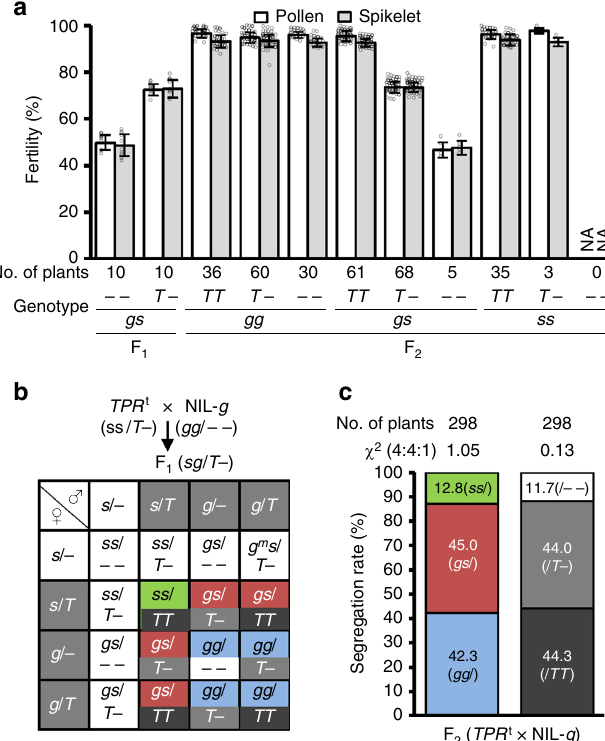
Fig. 2 The S1TPR t rescues the gametes carrying S1-s in hybrids. a Pollen and spikelet fertilities of the F 1 plants derived from the cross between the hemizygous S1TPR t ( TPR t , ss / T – ) and NIL- g ( gg / – – ), and various genotypes of the F 2 segregants. Error bars indicate S.D. NA, not available. b A proposed model for the segregation behavior of the endogenous S1 alleles and TPR t in the F 2 plants derived from TPR t × NIL- g . The F 1 male and female gametes containing S1-g and/or T are considered fertile, and those with S1-s ( ss / – – ) but lacking T are generally sterile. Thus, the expected segregation ratios for gg : gs : ss and TT : T – : – – are 4:4:1. The color codes are consistent with the genotype of the individuals in the F 2 population. Black represents homozygous TPR t ; gray represents hemizygous TPR t ; white represents lacking TPR t ; green represents homozygous S1-s ; red represents heterozygous S1 ; blue represents free homozygous S1-g . c The segregation rates of the S1 alleles and the transgene ( T ) in the analyzed F 2 population fi t the expected ratio. Source data of ( a , c ) are provided as a Source Data fi le